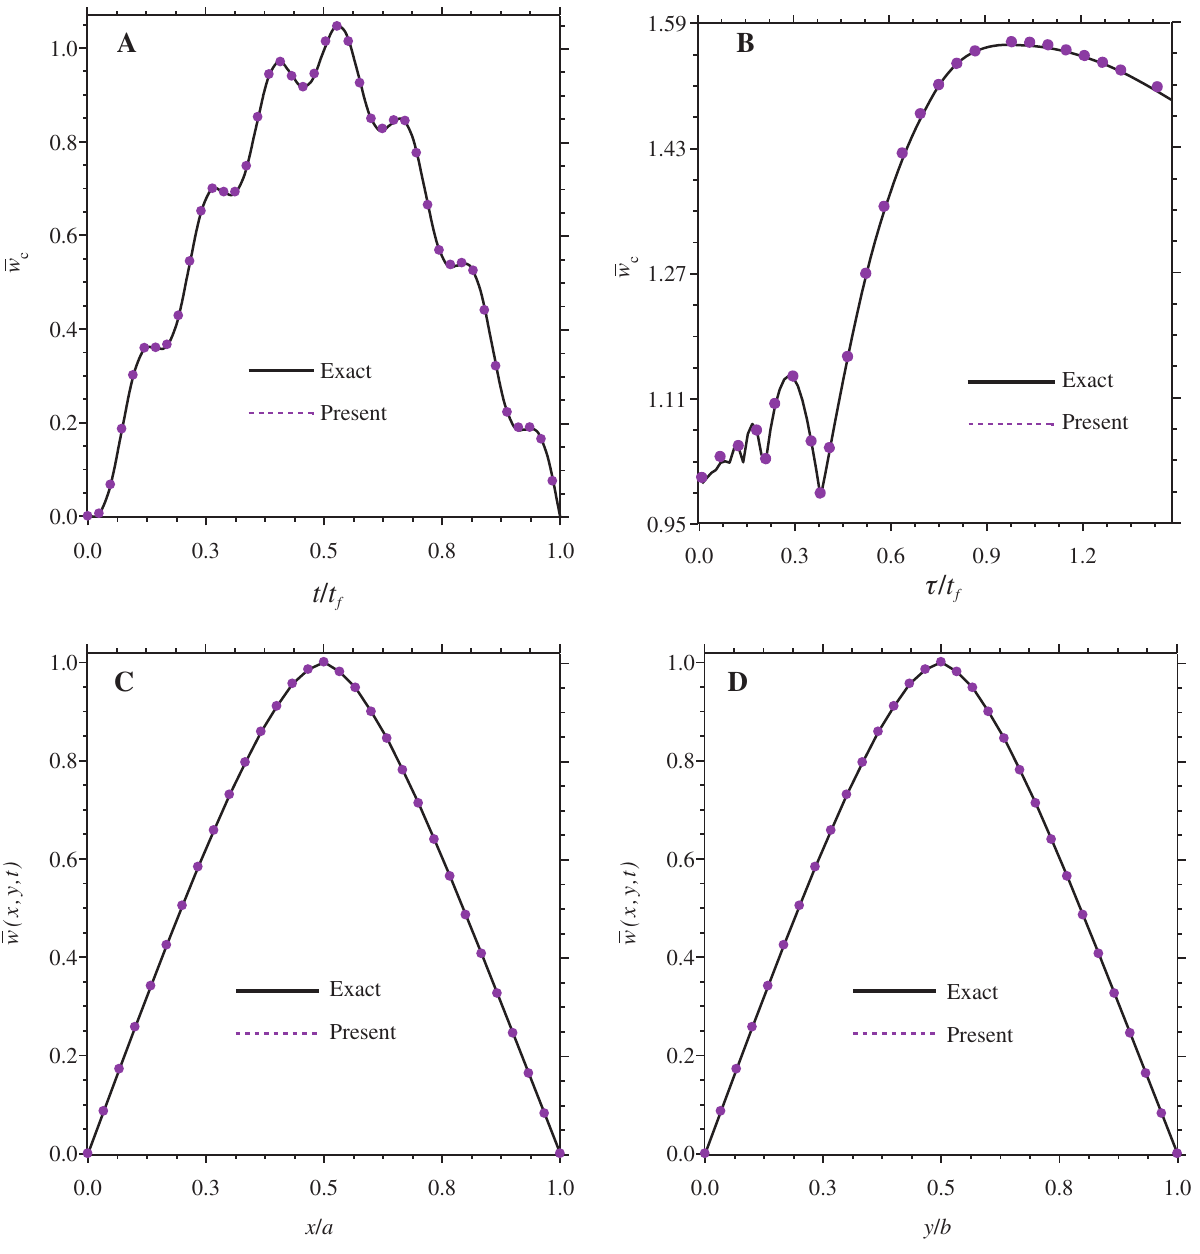
Figure 2 The accuracy of the dynamic behavior of simply supported isotropic plate: (A) the time history of the nondimensional center = 5 m/s), (B) the maximum normalized dynamic center deflection, (C) the profile of the material line y = b /2 ( v deflection ( v 0 (D) the profile of the material line x = a /2 ( v